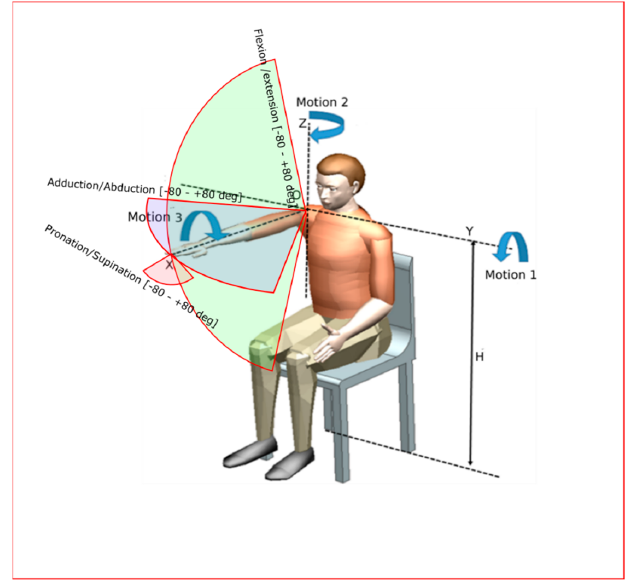
Figure 1. The targeted motion of ASPIRE [24].